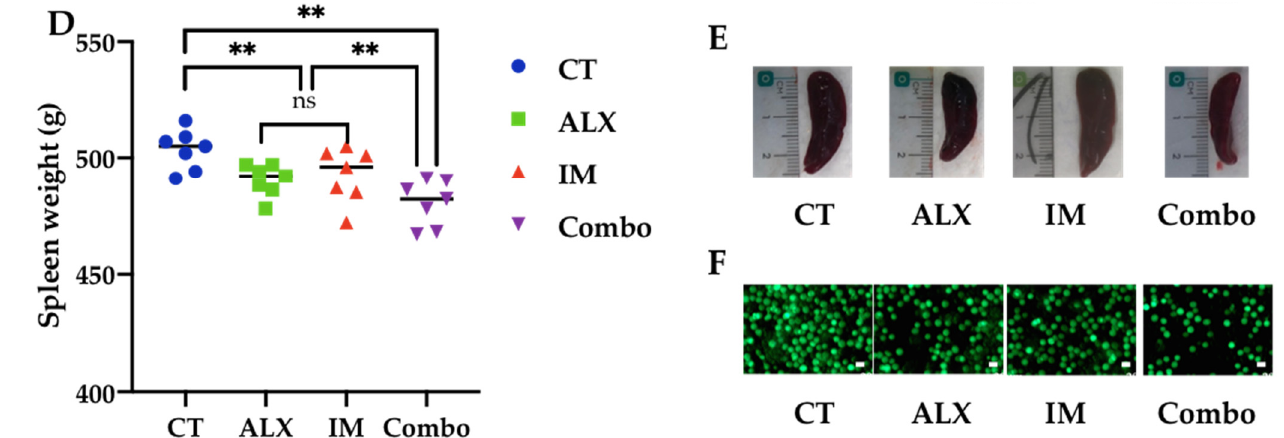
Figure 6. Combination of alexidine and imatinib increased leukemic mice’s survival. ( A ) Schematic design of the in vivo experiment. NSG mice (7 per group) were injected intravenously with GFP-K562-transduced cells. One day later, the mice were treated daily for 10 days with intraperitoneal injection of PBS (CT), 45 mg/kg imatinib (IM), 0.5 mg/kg of alexidine (ALX) or a combination (Combo). The last surviving mice were euthanatized at day 44. ( B ) Survival curves of mice according to the different treatments. ( C ) Two representative images of Biospace analysis of each indicated group of treated mice at day 15. ( D ) Quantification of the spleen weight of all mice in each group (unit = g); ** p < 0.01, 2-way ANOVA. ( E ) Photographs representing spleens of mice from each group that died between days 12 and 17. ( F ) GFP cell contents of the spleens presented in ( E